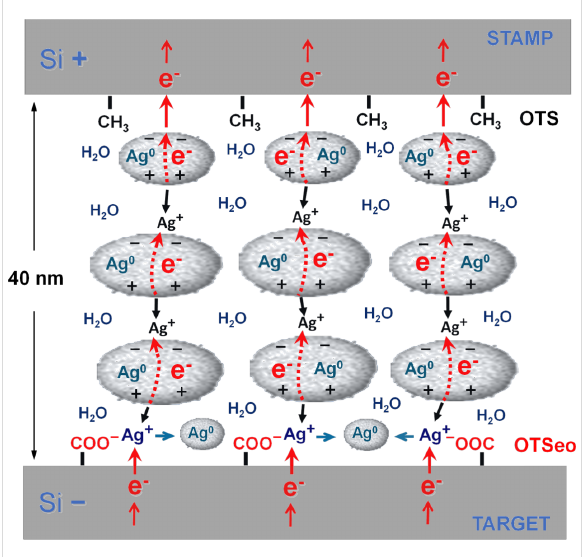
Figure 6: Proposed bipolar electrochemical mechanism of metal transfer from a thin, granular silver-film stamp (Ag/OTS/Si) to a carboxylic acid terminated target monolayer (OTSeo/Si) in a contact electrochemical configuration like that depicted in Figure 1 (see text). Key features emphasized in this schematic illustration (not to scale) are the nanoscale thickness of the granular silver film,